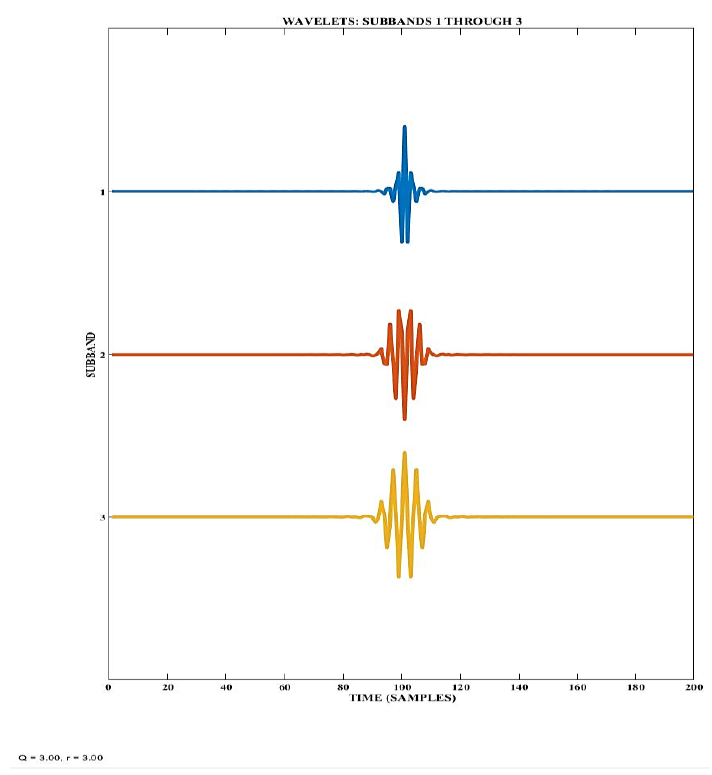
Figure 9. 3D curve of optimizing adaptive parameters for HIF.